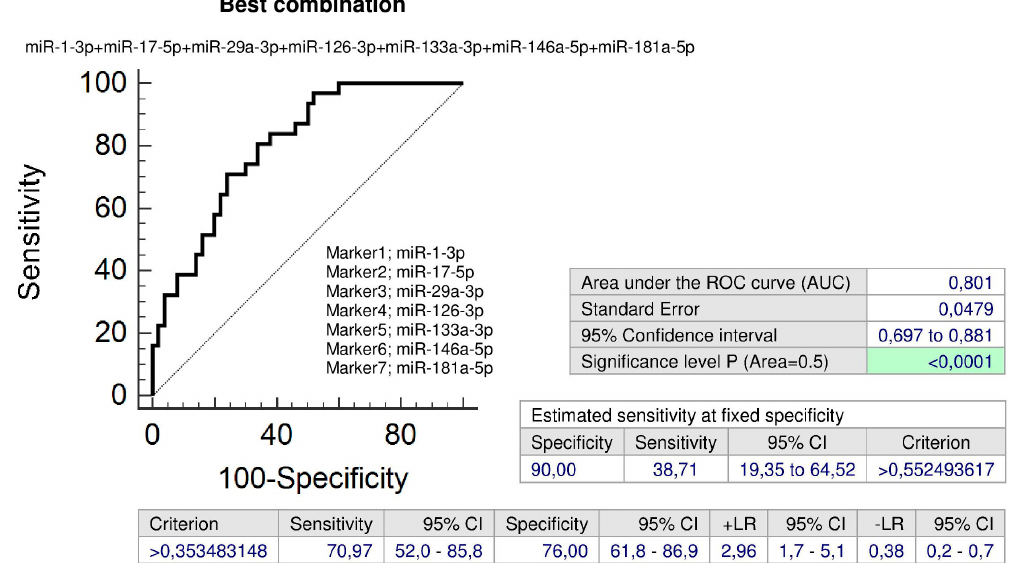
Figure 8. Combined postnatal screening of microRNAs in the identification of children with abnormal postnatal clinical findings descending from GH pregnancies. Postnatal combined screening of miR-1-3p, miR-17-5p, miR-29a-3p, miR-126-3p, mir-133a-3p, miR-146a-5p, and miR-181a-5p showed the highest accuracy for the identification of children with abnormal clinical findings with a prior exposure to GH at an increased risk of later onset of cardiovascular/cerebrovascular diseases.